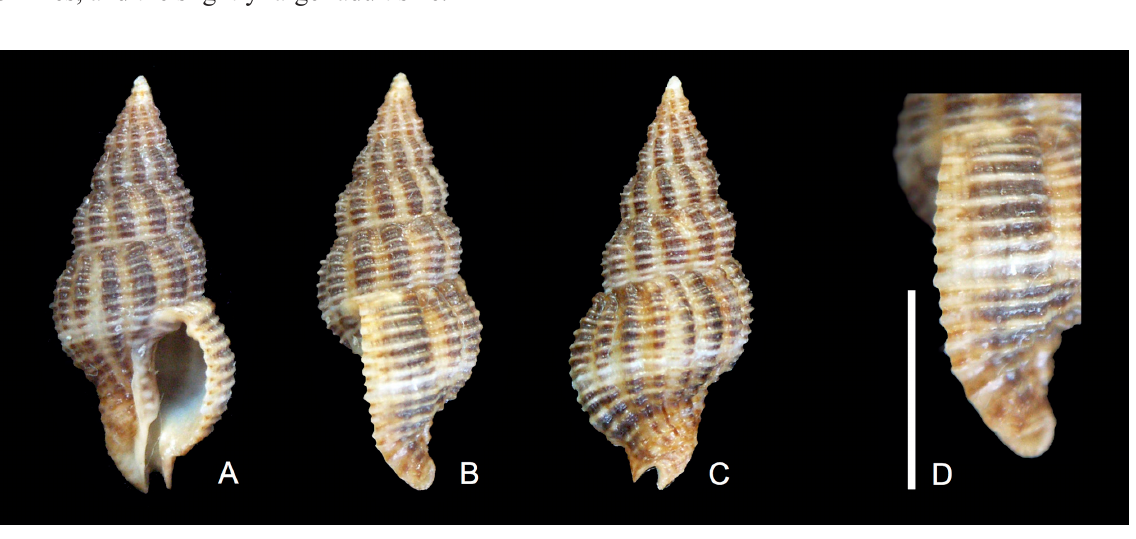
Fig. 7A–D. Sinetectula nigricostata (Reeve, 1846) gen. et comb. nov., Panama, Gobernadora, low tide, 19.6 mm long (KF 3378). Scale bar: 5